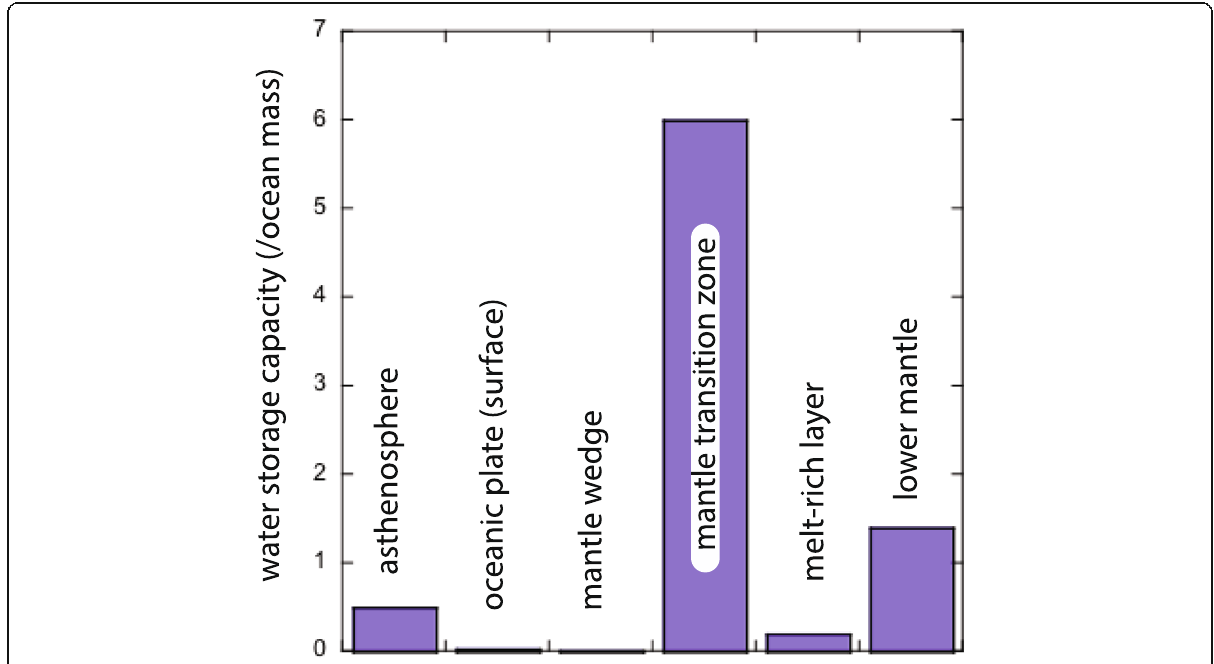
Fig. 2 The water storage capacity in several regions of the mantle. Note a large water storage capacity in the mantle transition zone. For the data source and uncertainties, see Table 1